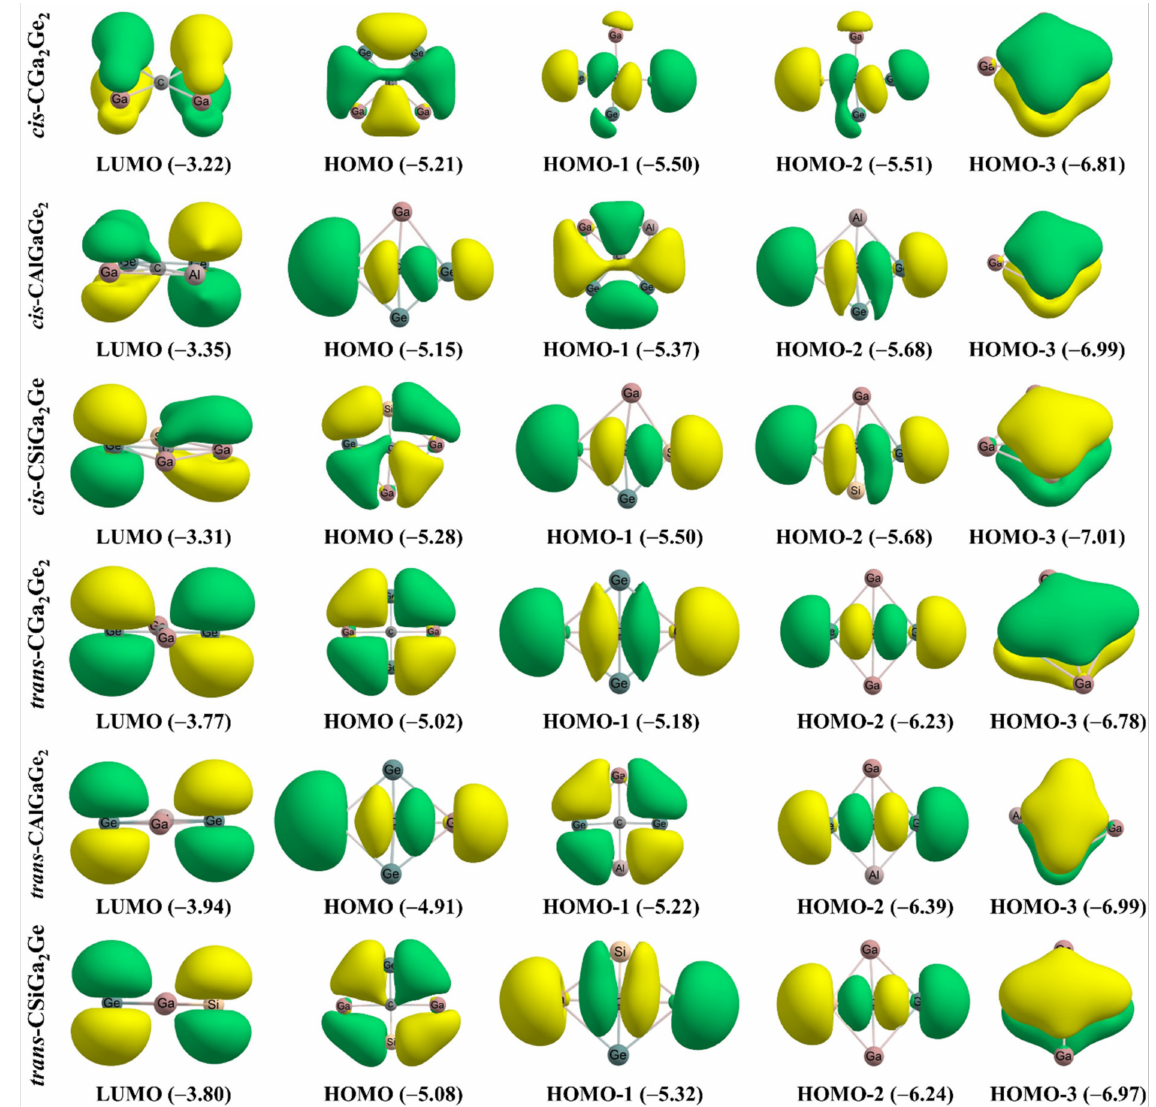
Figure 5. Plots of the molecular orbitals of the systems. The values in the parenthesis are the energies of the corresponding orbitals in the eV